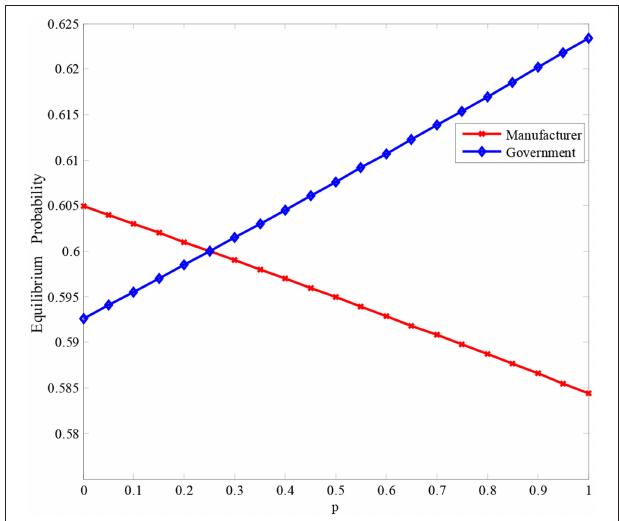
FIGURE 6 | Game members’ equilibrium probabilities as a function of p .